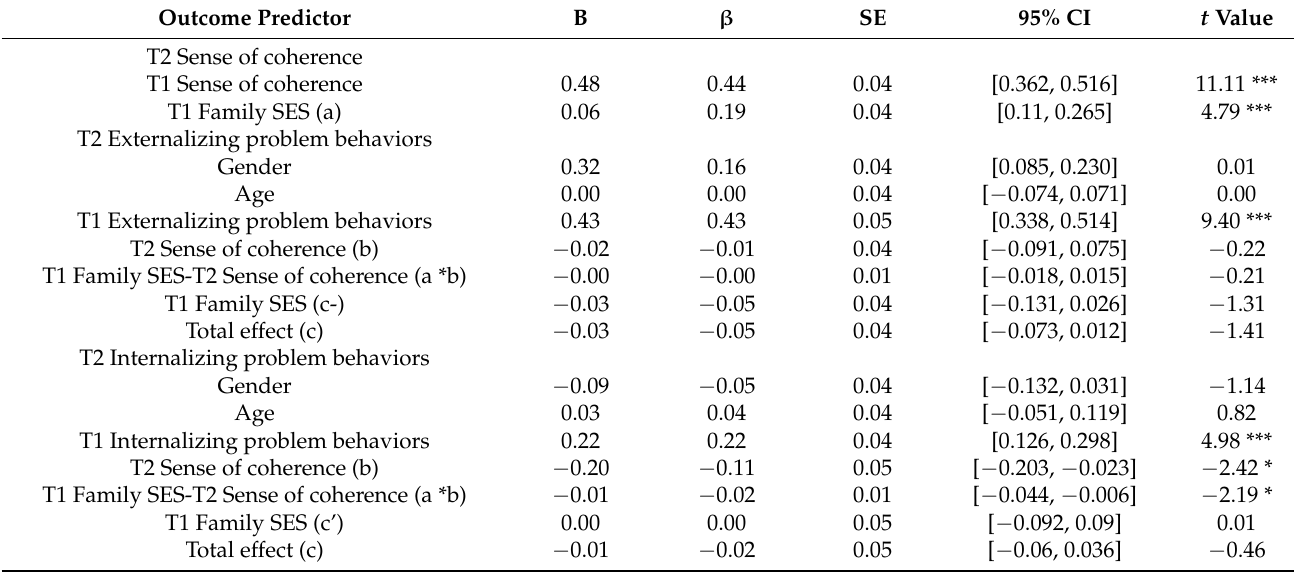
Table 2. Mediated Role of Sense of Coherence on Longitudinal Relation Between Family SES and Problem